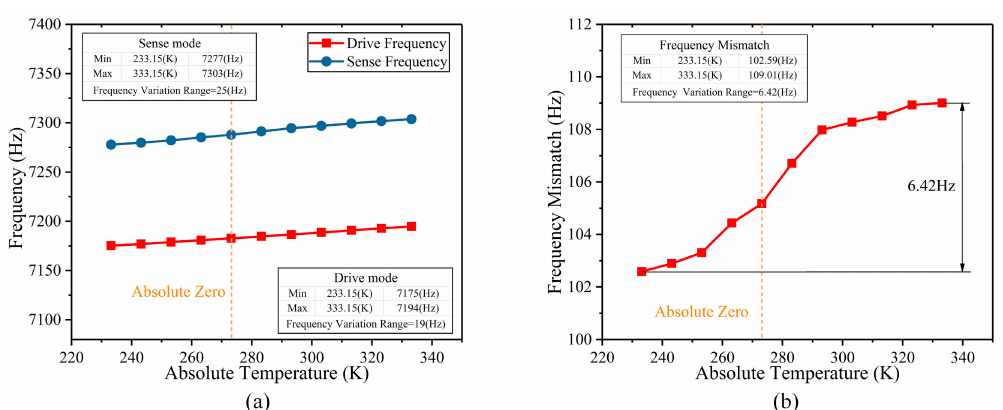
Figure 12. The electron microscope photos of the sensing structure of the BFVG.